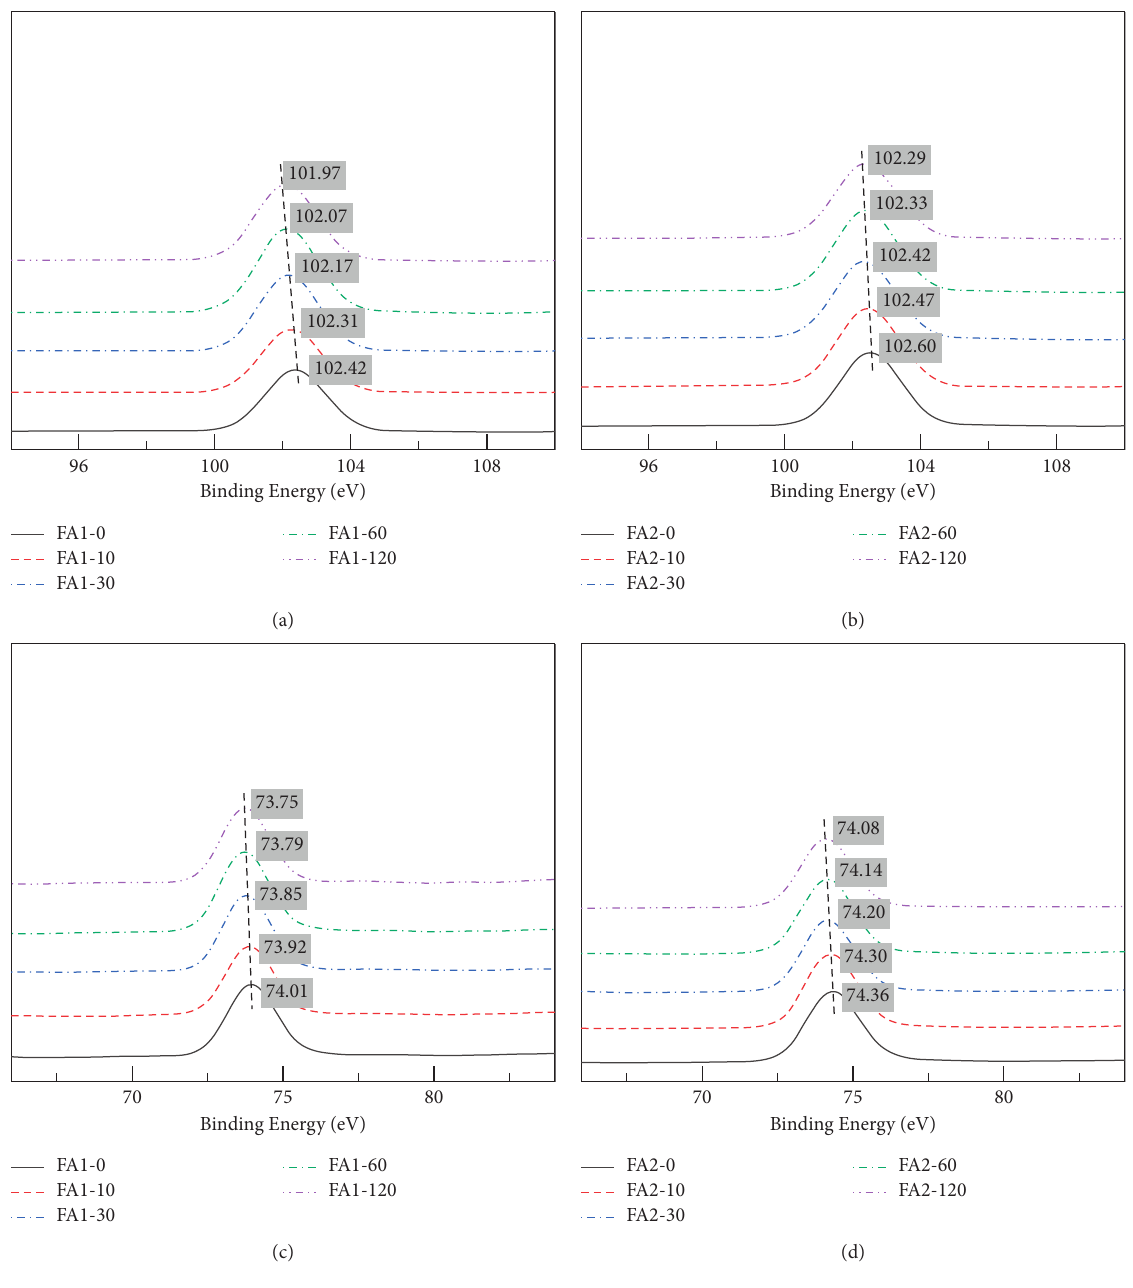
Figure 5: XPS analysis results: (a, b) Si 2p and (c, d) Al